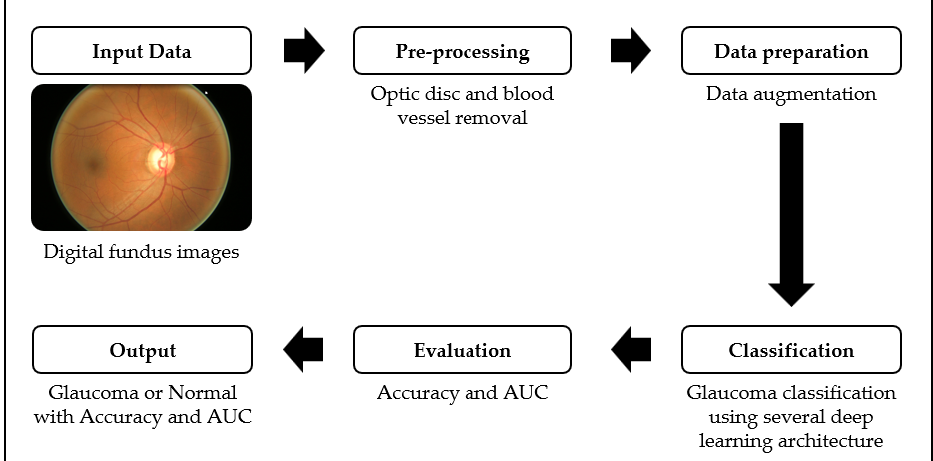
Figure 2. Flowchart of our proposed method.